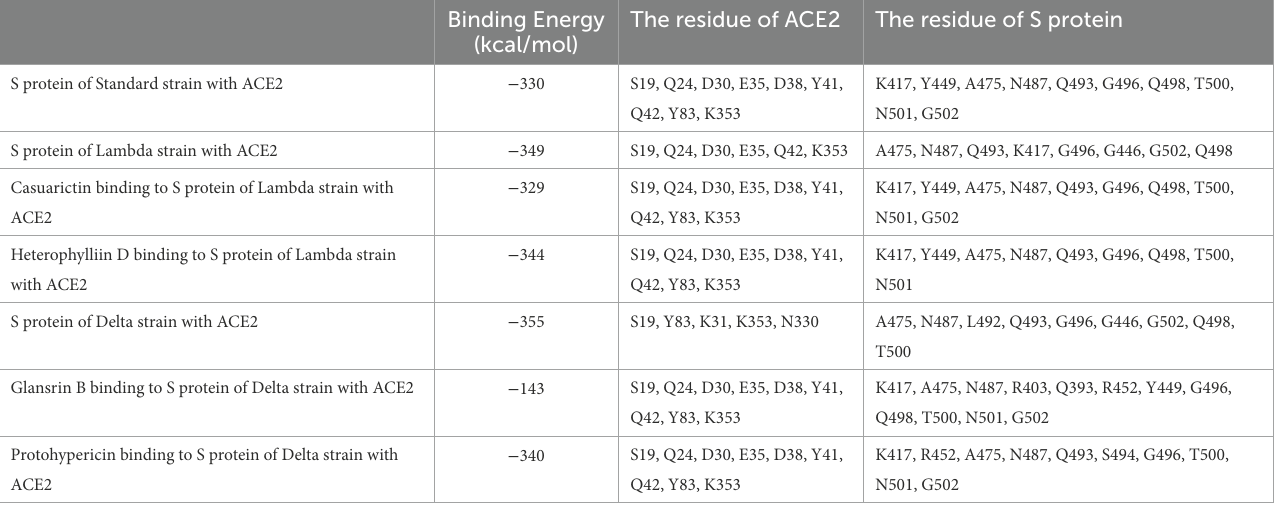
TABLE 7 The results of protein–protein docking.